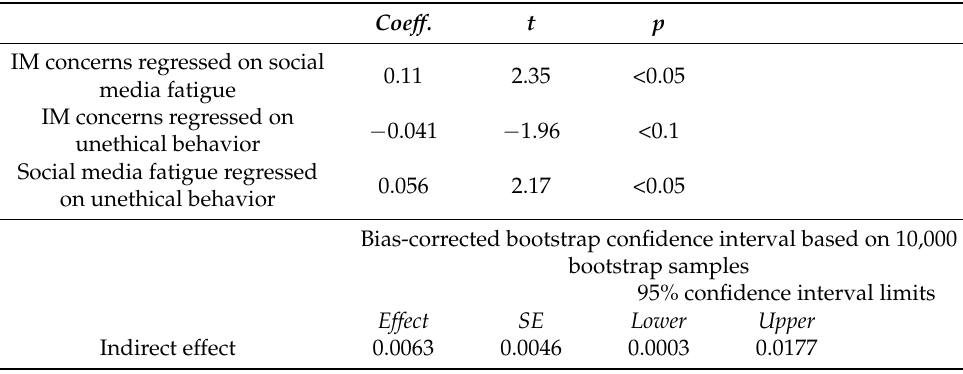
Table 4. Regression results for simple mediation. Coeff. t